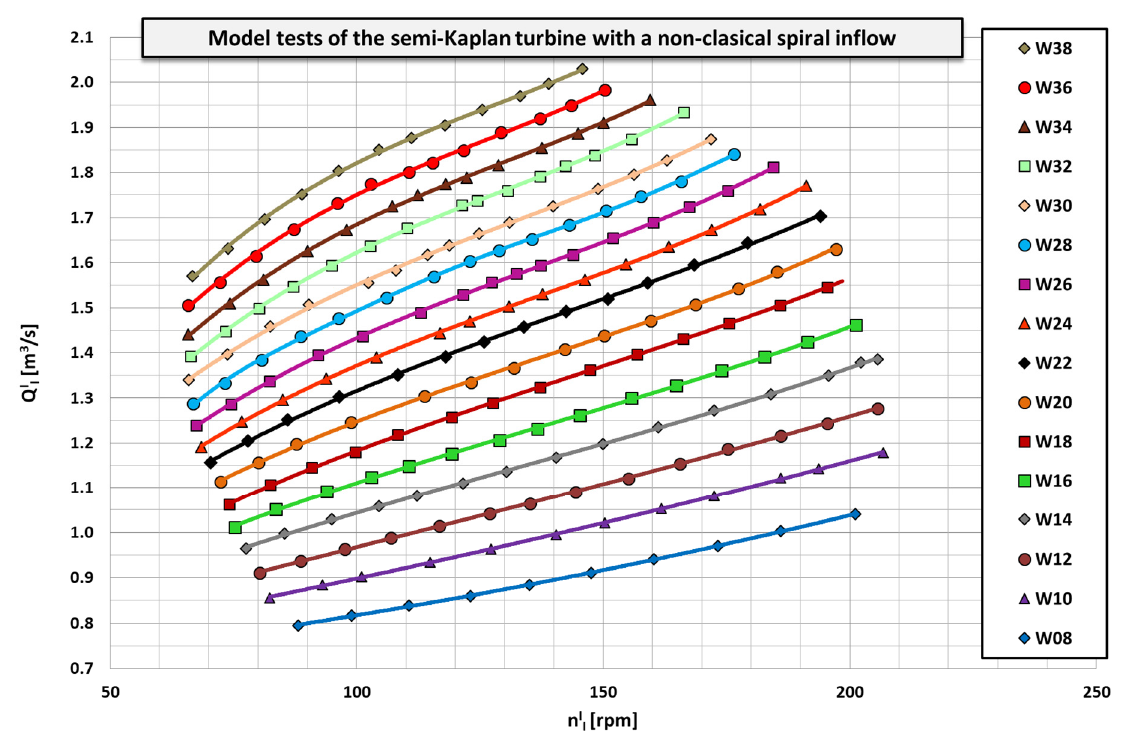
Figure 14. Efficiency curves of the semi-Kaplan model turbine as a function of the double-reduced